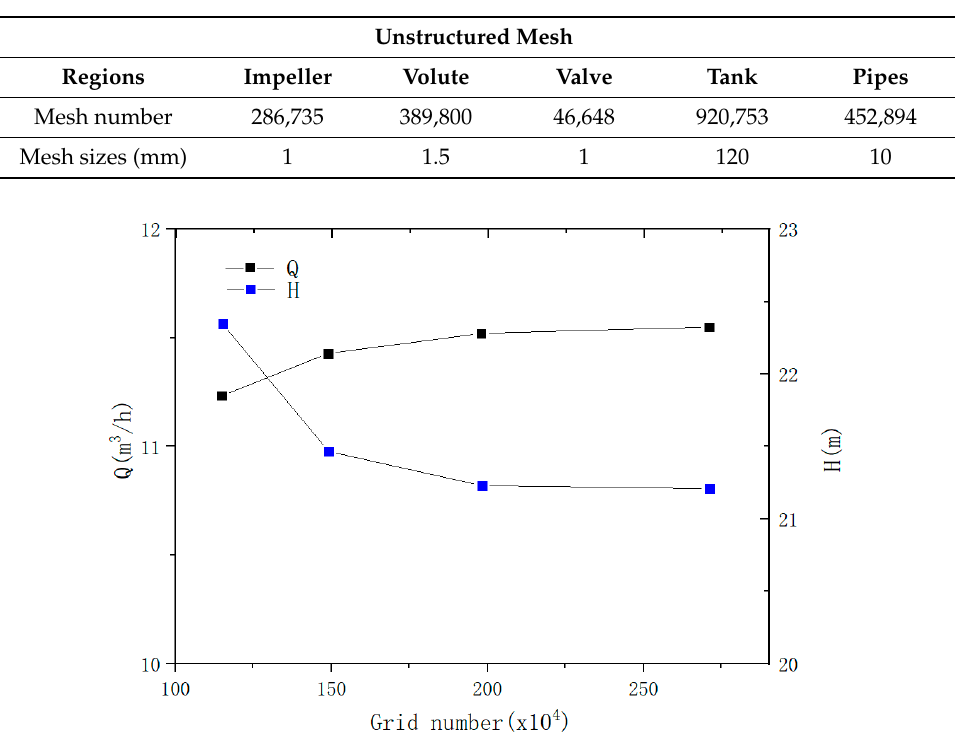
Figure 12. Results of the grid independence investigation.